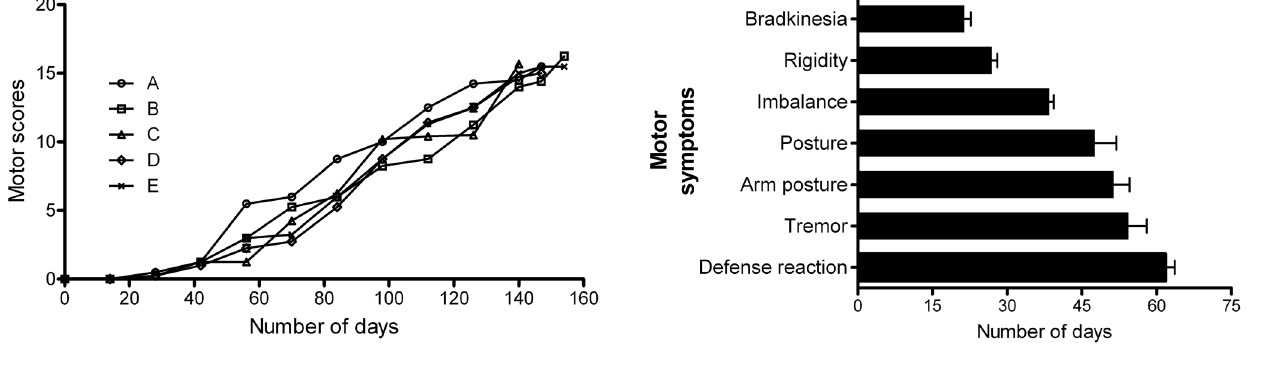
Figure 2. The appearance of individual PD symptoms in monkeys given MPTP intoxication. This graph presents the average day of appearance for each symptom. Error bars indicate the SEM for appearance of each symptom